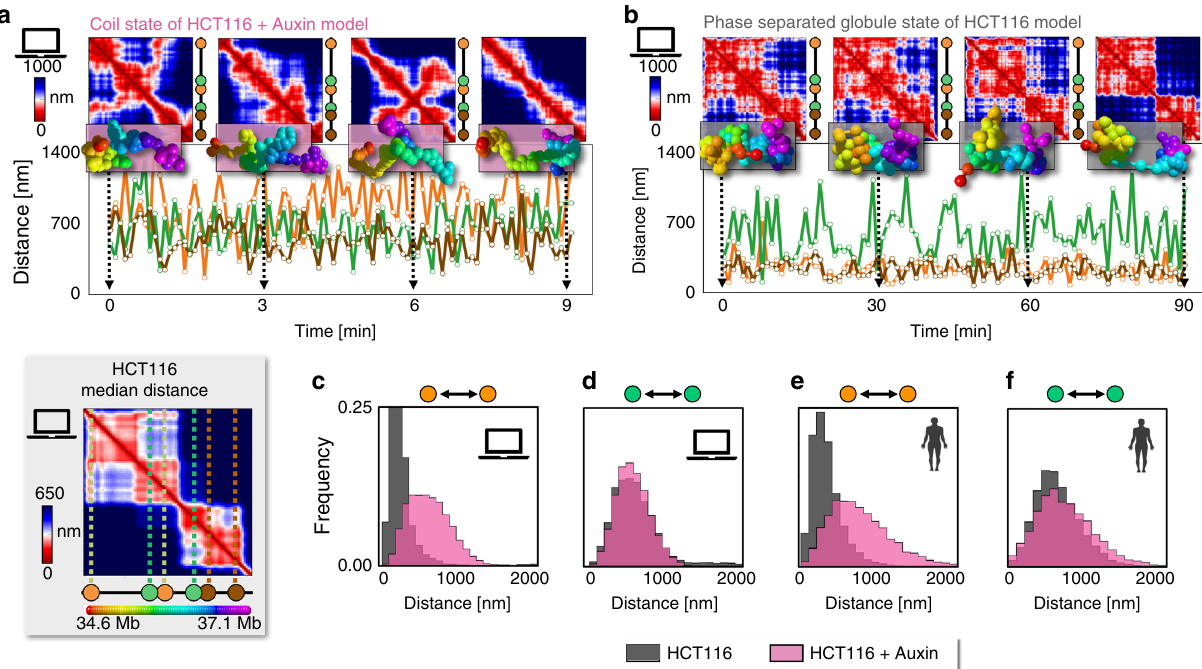
Fig. 4 The time dynamics of single molecules illustrates how globules establish speci fi c contacts and boundaries. The steady-state time behavior is shown of a single-molecule and its distance matrix in the model of the chr21:34.6 – 37.1 Mb locus in cohesin depleted (HCT116 + Auxin coil state, a ) and wild-type cells (HCT116 globule state, b ). The relative distances are also plotted of: (i) a pair of sites (orange), 1.2 Mb apart, in different subTADs, having a strong point-wise (loop) interaction in WT HCT116; (ii) a pair of 0.6 Mb distant sites (green) with a TAD boundary in between; (iii) a pair of sites (brown), almost 0.6 Mb apart within the same subTAD. a In the coil state, the distance time tracks of those sites have all wide fl uctuations, as contact patterns are fl eeting. b In the globule phase separated state, the interaction pattern shows that globules vary, but persist in time (see text). Hence, within their stochastic environment, close, speci fi c contacts are enhanced between site pairs sharing abundant cognate binding sites (orange and brown, Supplementary Fig. 13), whereas pairs in different globules remain insulated (green). c The orange pair is on average much closer (Supplementary Table I) and its distance distribution much narrower in the HCT116 than in the HCT116 + Auxin model, d whereas the green pair behaves similarly in both. e, f The model distributions are close to the corresponding experimental ones 37 in HCT116 and in HCT116 + Auxin cells, consistent with the view that chromatin folds in different thermodynamics states in WT and cohesin depleted